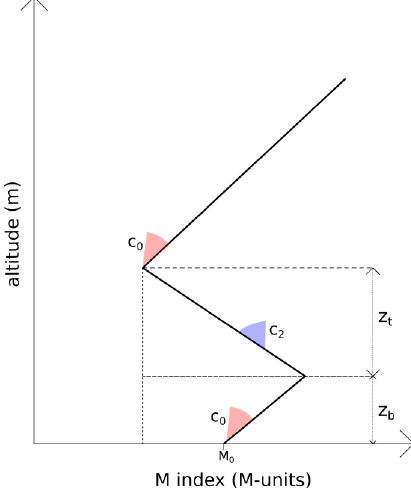
Figure 9. Tri-linear profile of